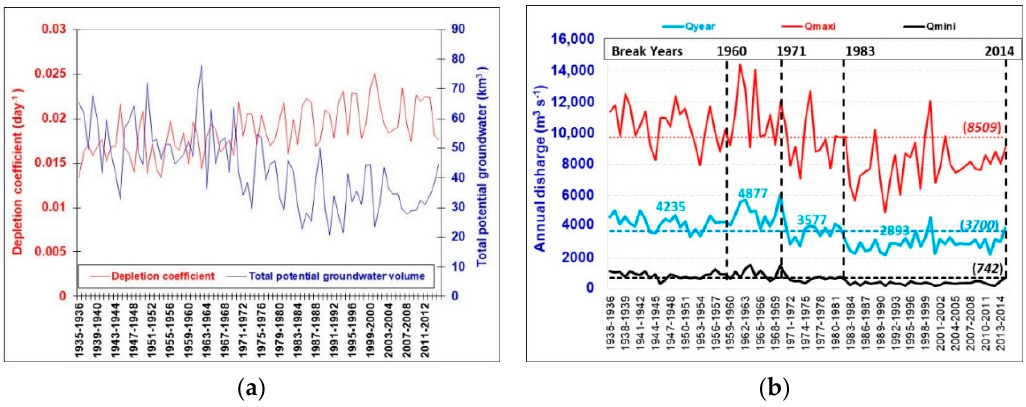
Figure 12. ( a ) Interannual evolution of the baseflow recession constant of the Ubangi River at Bangui and of the volume mobilized by the groundwater contribution of its catchment, from 1935 to 2015 hydrological cycles [3]. ( b ) Comparative evolution of annual (Qyear), maximum daily flood (Qmax), and minimum daily flood (Qmini) of the Ubangi at Bangui, from 1935 to 2015 [3].